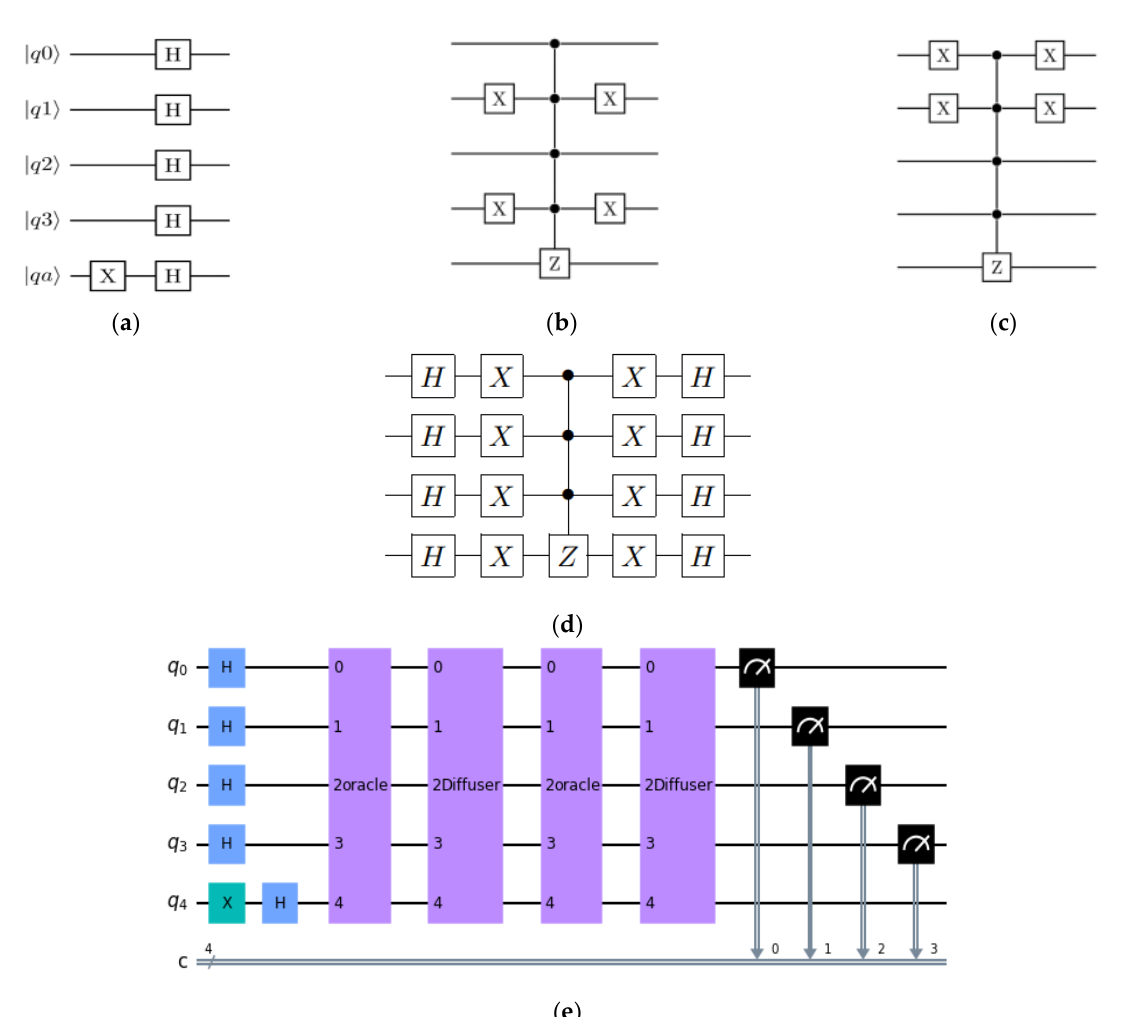
Figure 6. ( a ) Initialization of the quantum circuit; ( b , c ) represent Oracle marked states |1001⟩ and |1100⟩,(Note: the #1100 element is marked as (lsb to msb)) ; ( d ) the diffusion operator to invert the mean; ( e ) the complete quantum circuit ready to run on a simulator or quantum system to find the target element with high probability.